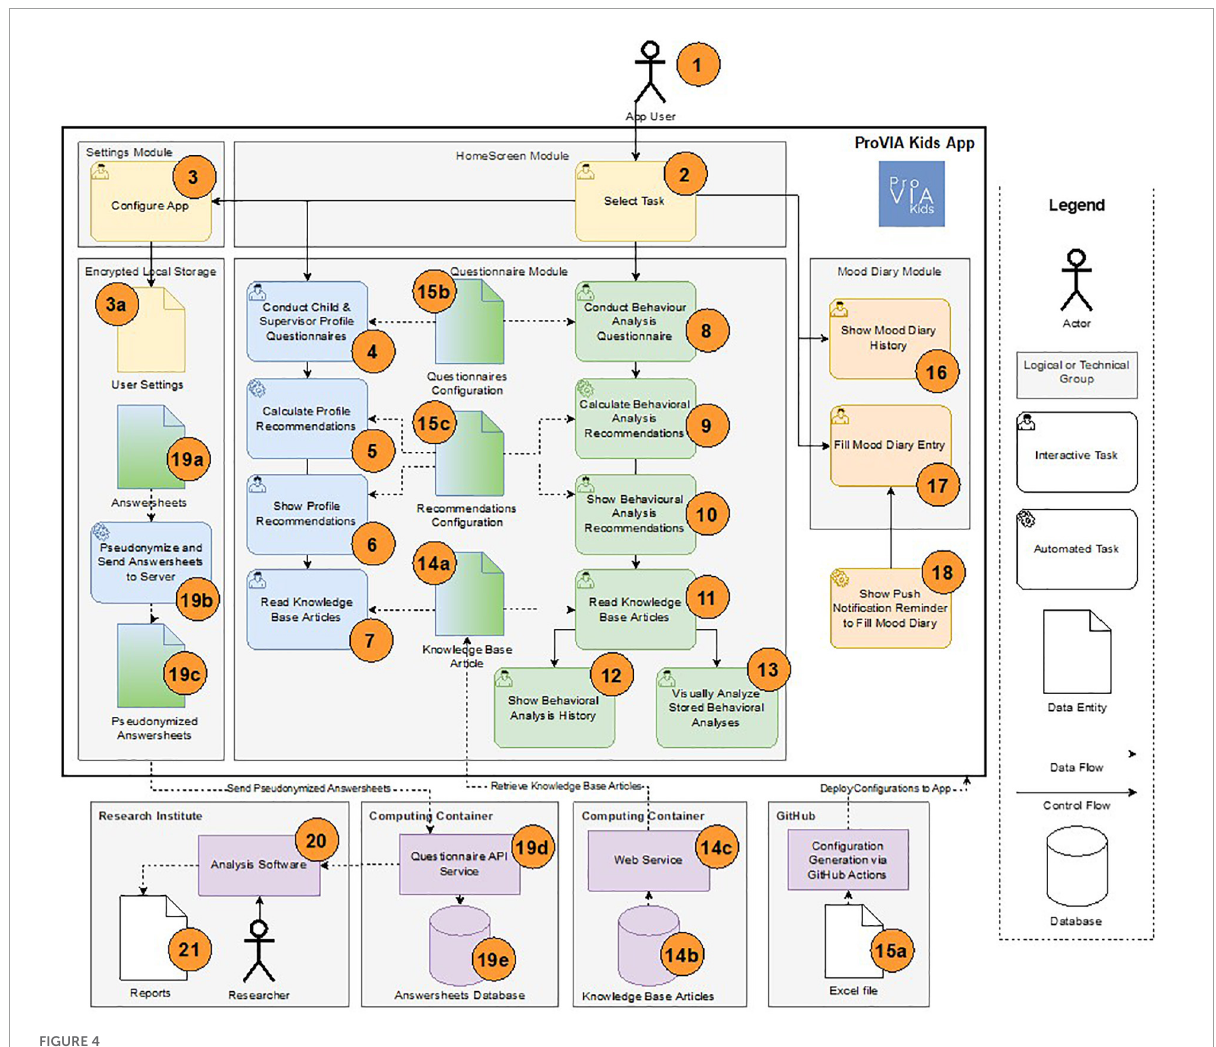
FIGURE4 Schematic architecture and workflow of the ProVIA-Kids